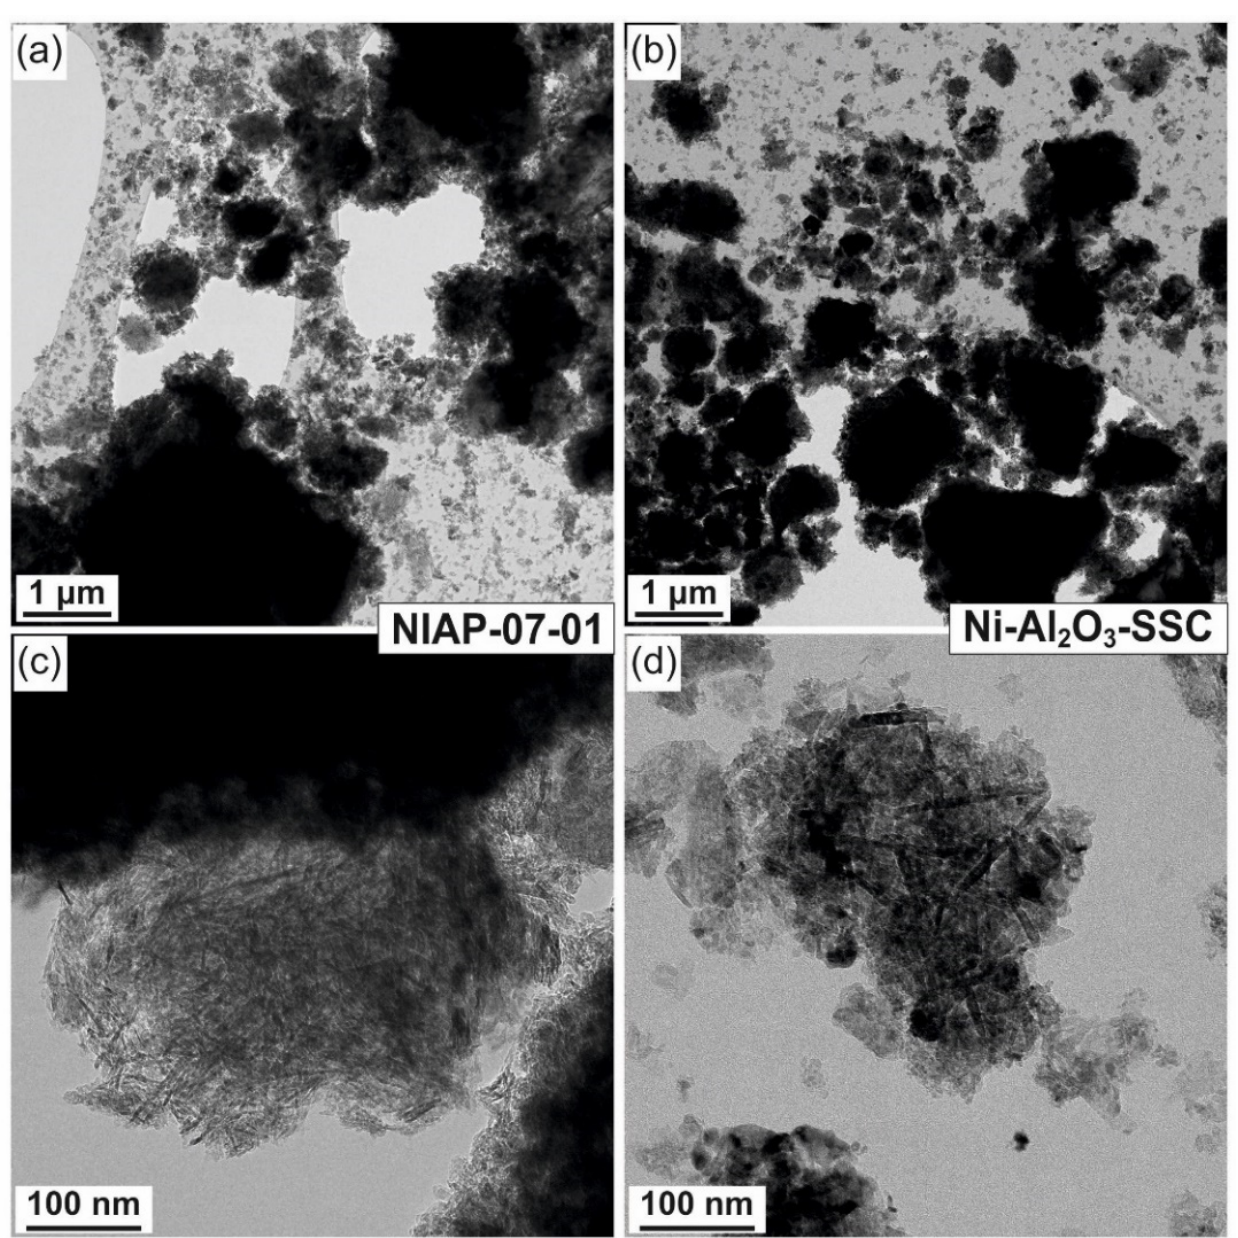
Figure 6. Morphology of ( a ) NIAP-07-01 and ( b ) Ni-Al 2 O 3 -SSC catalysts, as well as individual particles of ( c ) NIAP-07-01 and ( d ) Ni-Al 2 O 3 -SSC catalysts.